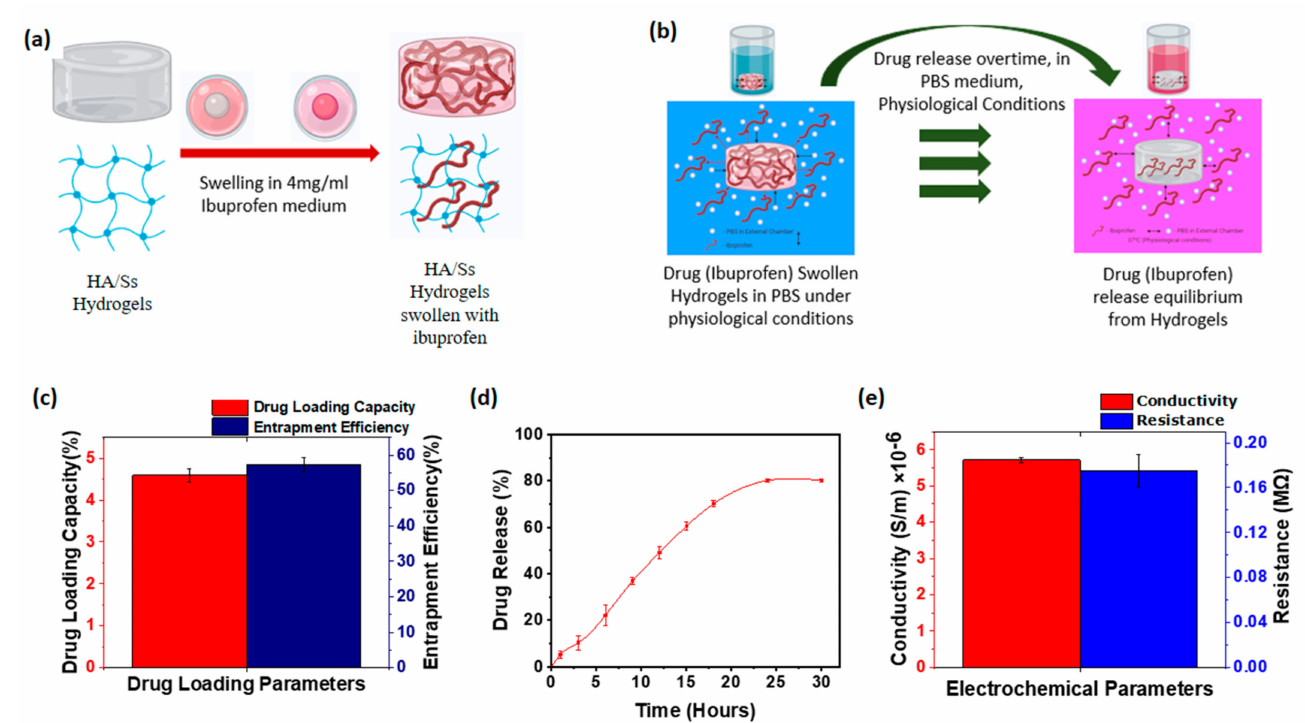
Figure 4. ( a ) Schematic diagram of drug (ibuprofen) loading on hyaluronic acid/spider silk-based hydrogels. ( b ) Schematic diagram of drug (ibuprofen) release from hyaluronic acid/spider silk-based hydrogels. ( c ) Drug (ibuprofen) loading capacity and drug (ibuprofen) entrapment efficiency of hyaluronic acid/spider silk-based hydrogels as drug (ibuprofen) loading parameters (HA/Ss 2). ( d ) Drug (ibuprofen) release (%) over time (HA/Ss 2). ( e ) Resistivity and conductivity of the hydrogels representing electrochemical parameters of the hyaluronic acid/spider silk-based hydrogels (HA/Ss